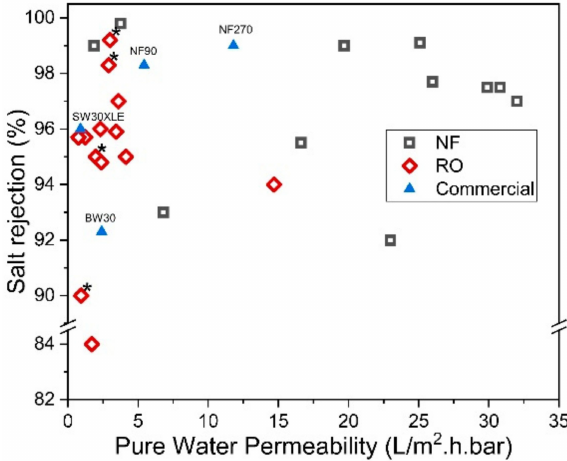
Figure 14. Salt rejection (Na 2 SO 4 for NF and NaCl for RO) and water permeability of membranes made of novel IP techniques. (* Note: The data were obtained from water permeability of 2000 ppm NaCl